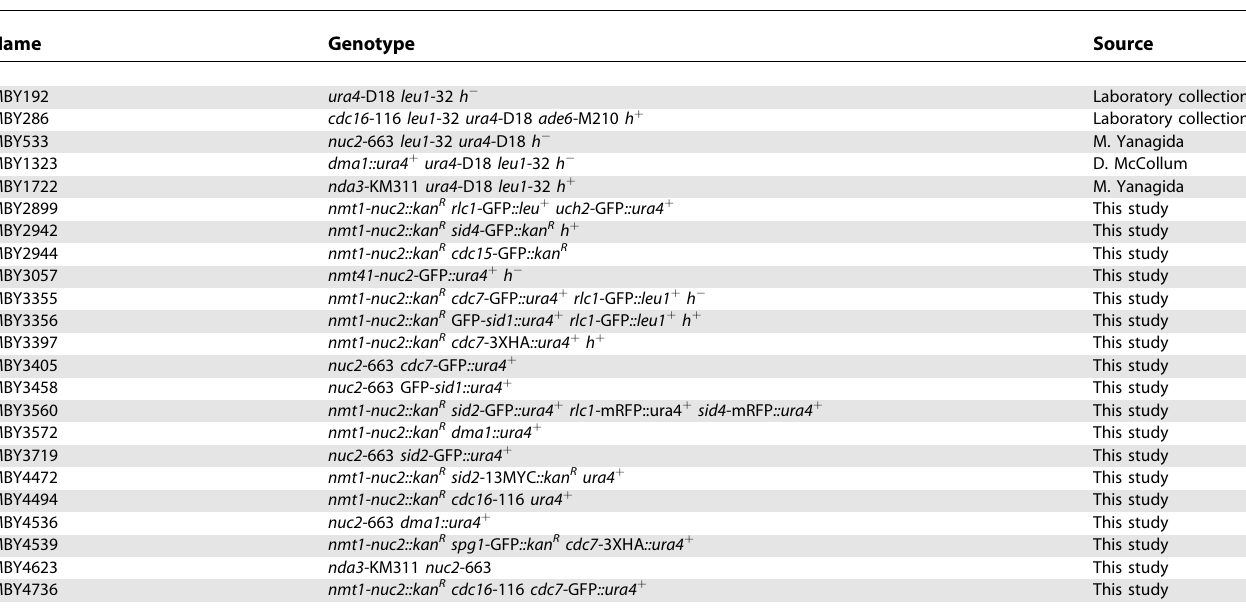
Table 1. S. pombe Strains Used in This